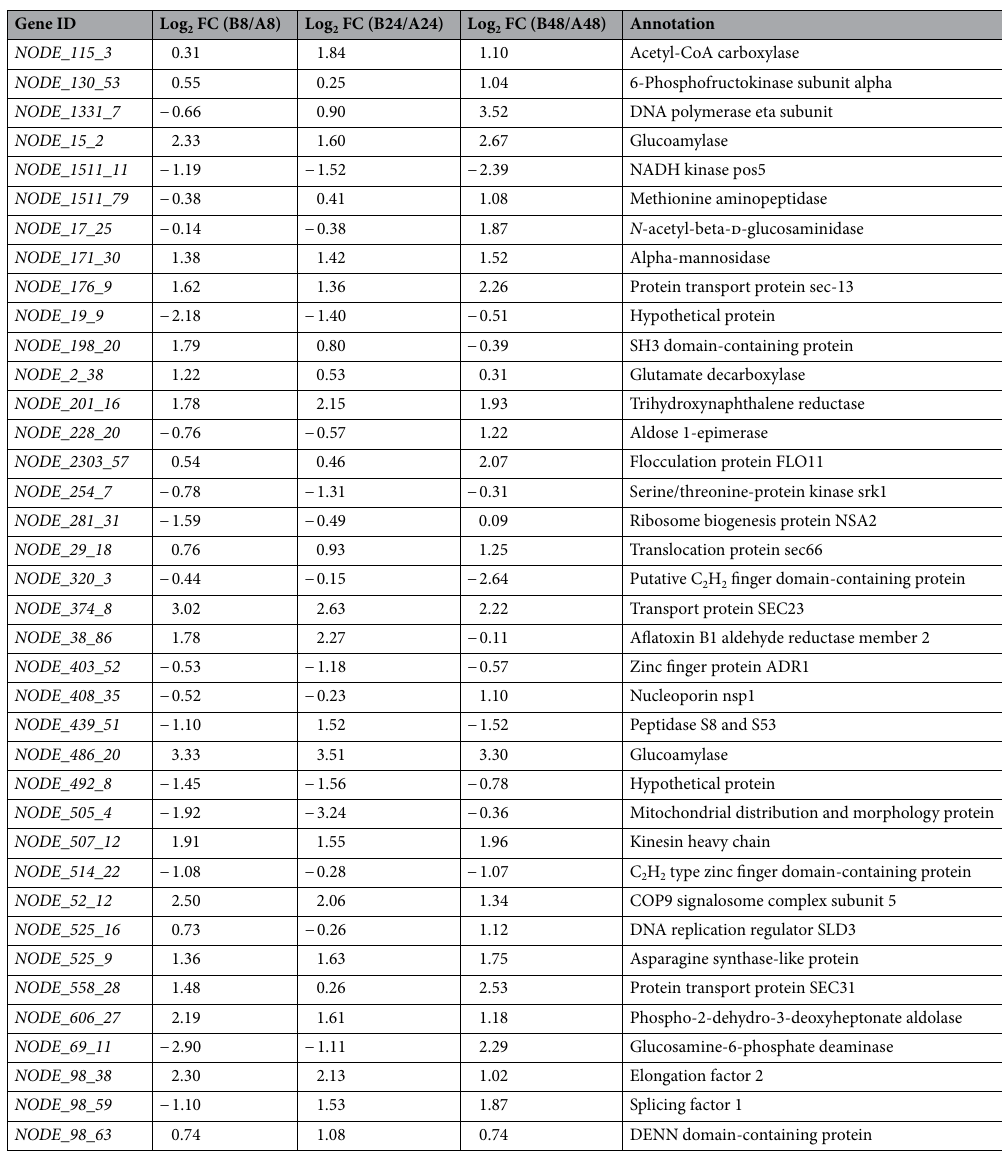
Table 1. Genes interacting with Crmapk that are differentially expressed in the transcriptome of C. chloroleuca 67-1 parasitising S. sclerotiorum . Log 2 FC, the abbreviation of Log [base 2] fold change, represents the relative expression of each gene (log2 value) between the control and treatments. The letter “A” represents the controls (samples without sclerotia) and “B” represents the treatments induced by S. sclerotiorum sclerotia. The samples of two groups were collected at 8 and 24 h, respectively, and the data of gene expressions were derived from our previous research 9